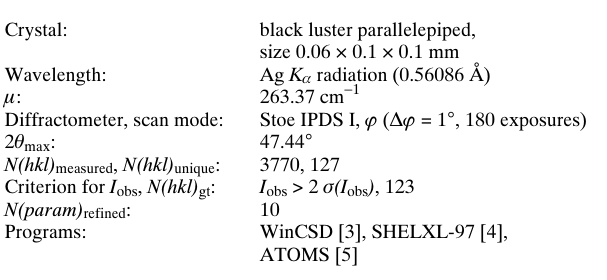
Table 1. Data collection and